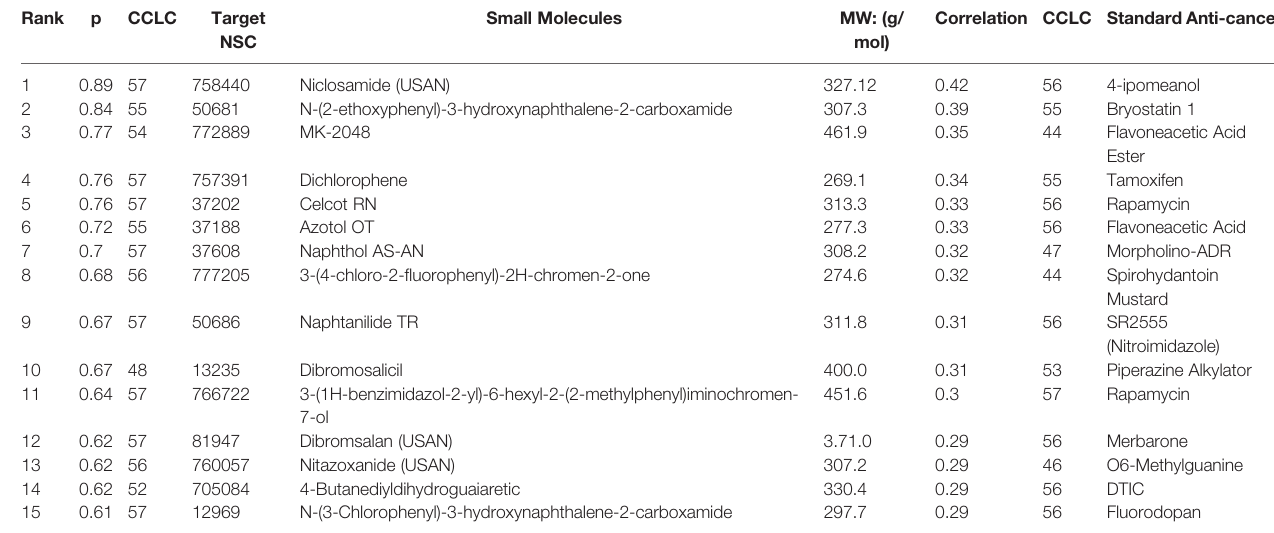
TABLE 6 | NCI synthetic compounds and standard anticancer agent sharing similar anti-cancer fi ngerprints and mechanistic correlation with